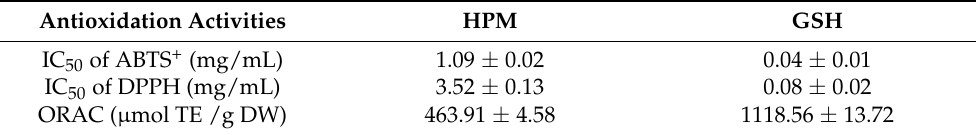
Table 2. In vitro antioxidant activities of HPM and